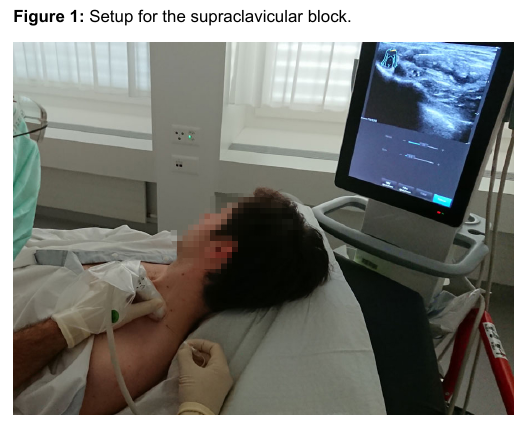
Figure 1: Setup for the supraclavicular block.